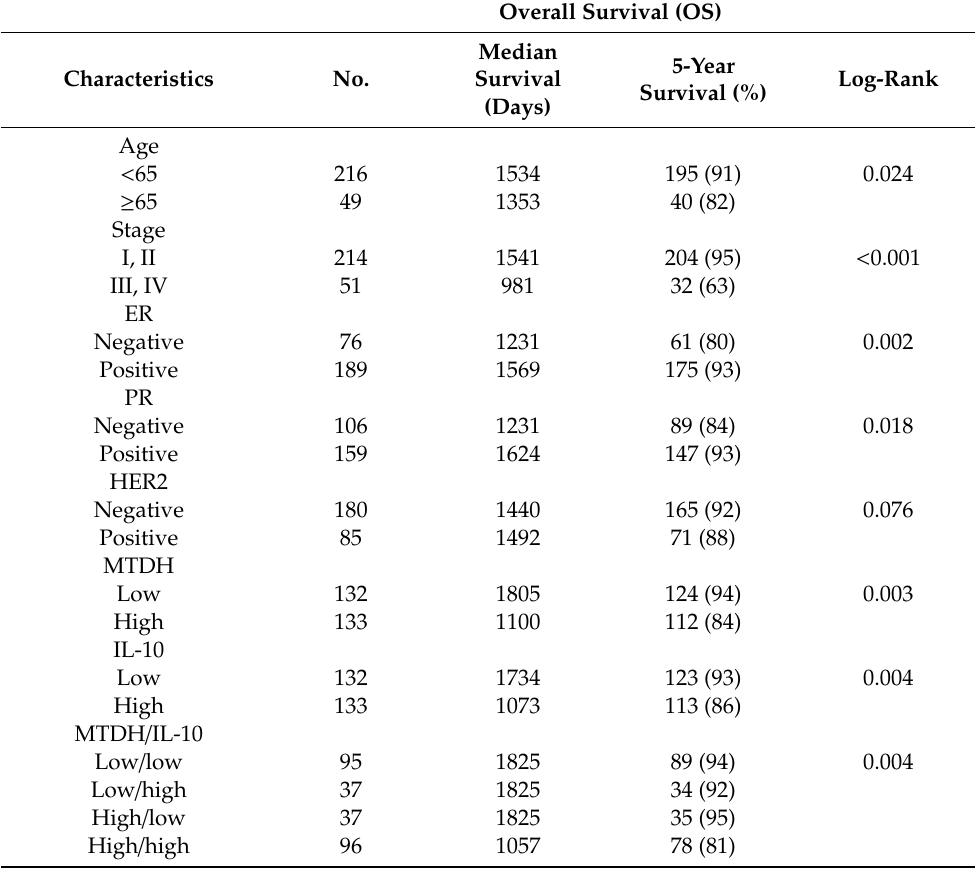
Table 2. Univariate analysis of influence of clinical characteristics on overall survival in 265 breast carcinoma